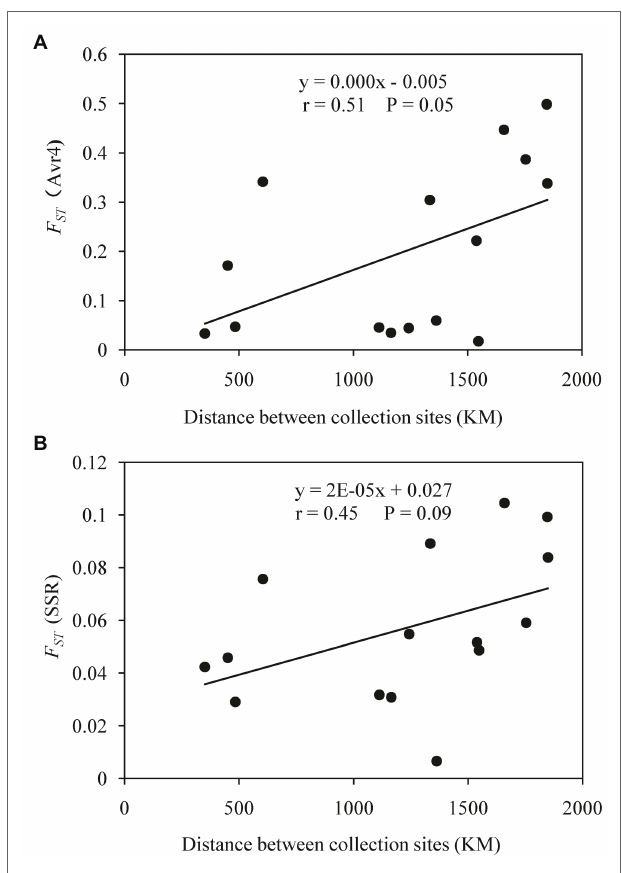
FIGURE 5 | Isolation by distance analysis (IBD) of genetic differentiation in the Avr4 and SSR marker loci of P. infestans populations sampled from China: (A) FST of the Avr4 gene and (B) FST of the SSR marker